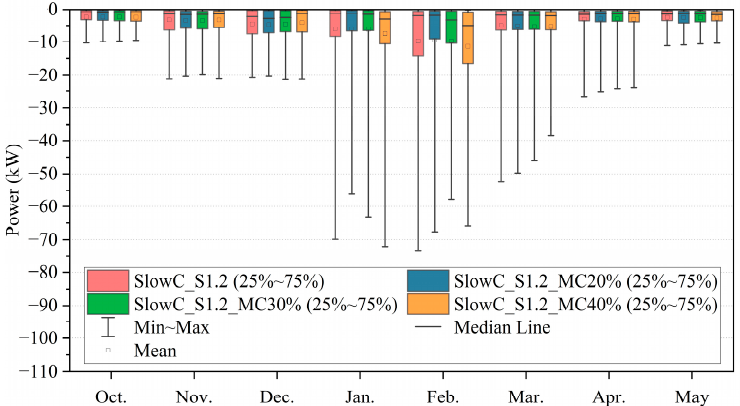
Figure 15. Values of P − flexibility factor for each month in the heating season (14 October–7